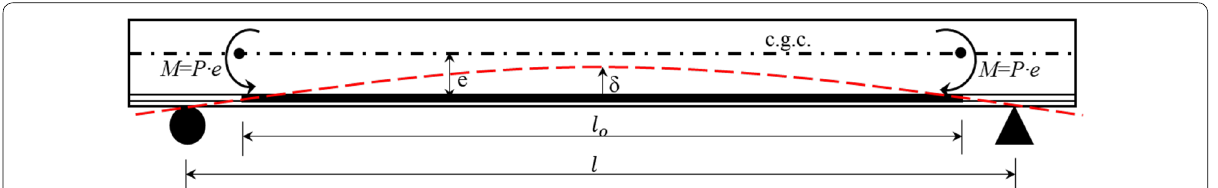
Fig. 11 Schematic of camber deflection by prestressing force.